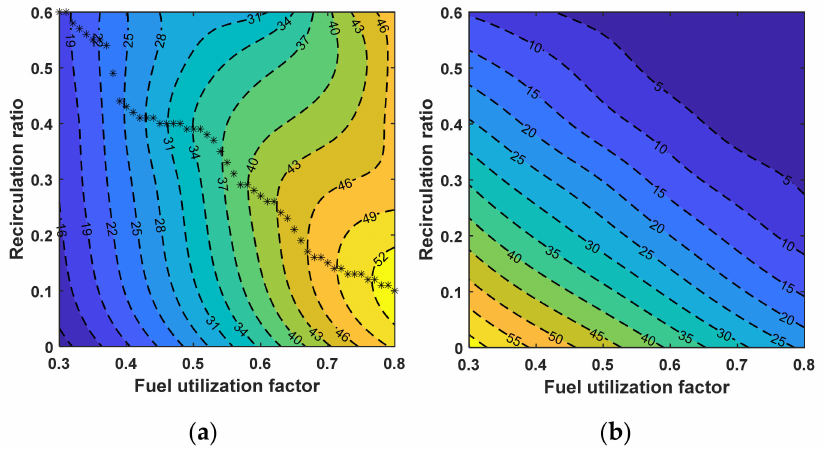
Figure 11. Efficiency of the AOGR #2 system with various fuel utilization factors and recirculation ratios; ( a ) electrical and ( b ) thermal